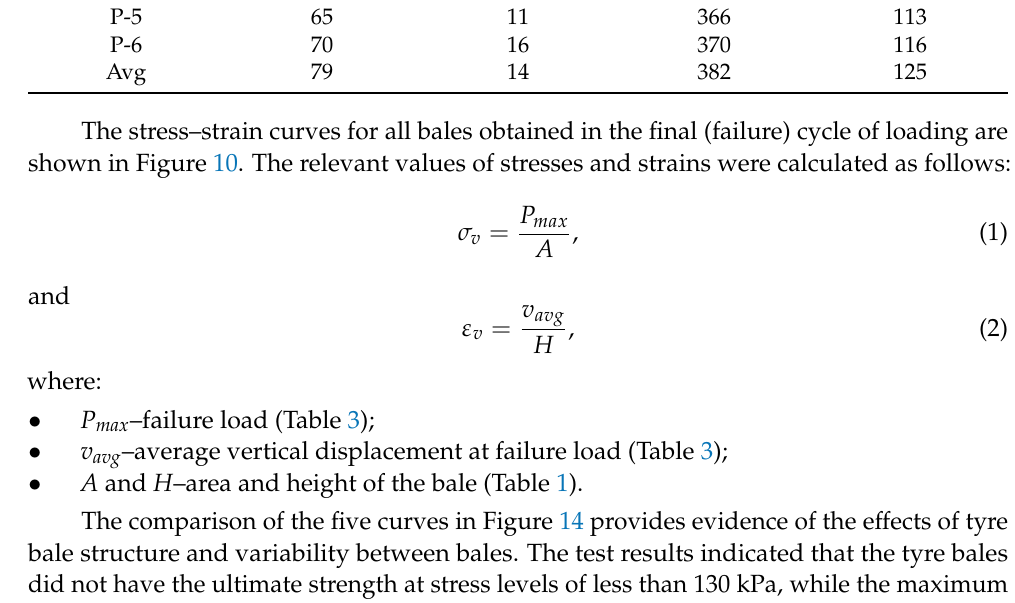
Table 3. Average vertical and horizontal displacements at P = 250 kN and at failure load. v avg (P 250kN ) h avg (P 250kN ) P max v avg (P max ) Bale No. [mm] [mm] [kN] [mm] P-1 102 25 436 156 P-2 90 116 P-3